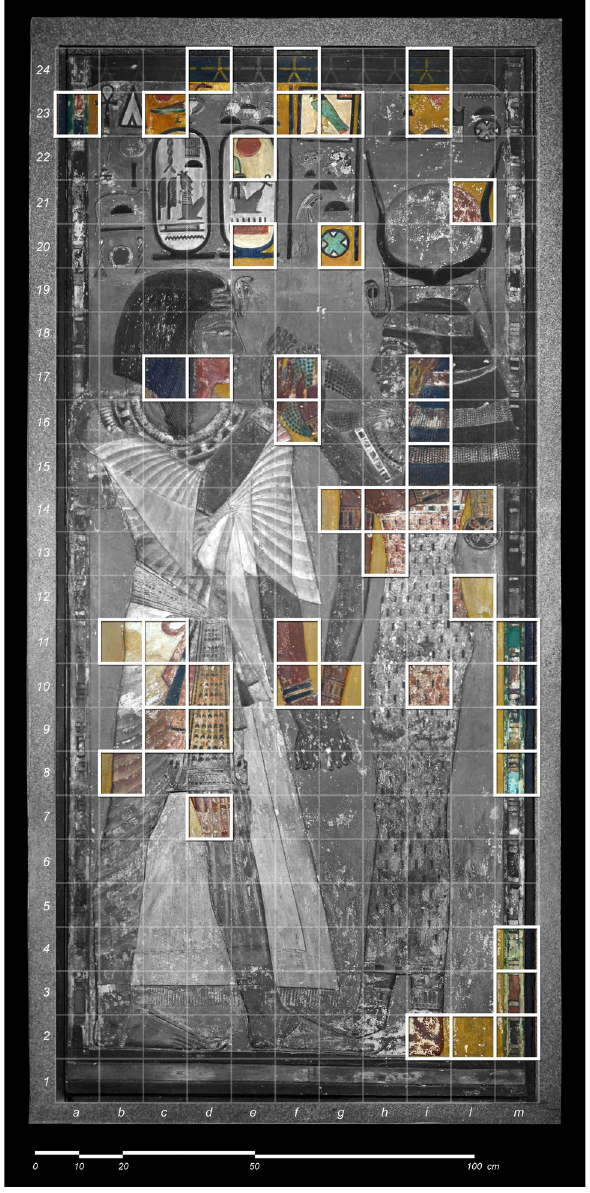
Figure 5. Sampling of the surface with the selected